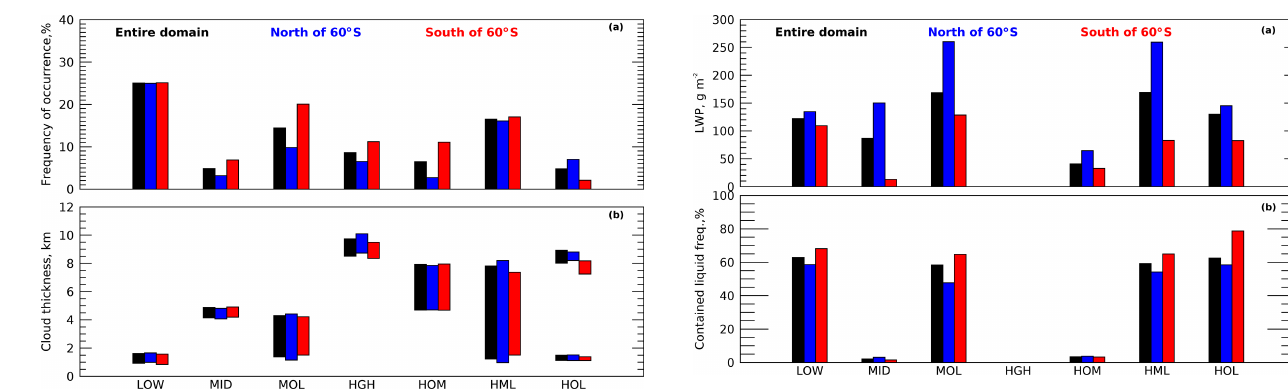
Figure 3. (a) Occurrence frequencies of categorized clouds by their vertical structures. LOW refers to single-layered low clouds ( H base and H top ≤ 3km). MID refers to single-layered middle clouds ( H base > 3km and H top ≤ 6km). MOL refers to MID over LOW ( H base < 3km and H top ≤ 6km). HGH refers to single- layered high clouds ( H base > 6km). HOM refers to HGH over MID (3km < H base < 6km and H top > 6km). HML refers to HGH over MID and LOW ( H base < 3km and H top ≥ 6km with a MID layer). HOL refers to HGH over LOW (LOW and HGH appear at the same time). (b) Cloud thickness for each type of cloud is shown with bars. The tops and bottoms of the bars represent the maximum cloud-top and minimum cloud base heights, respectively. Black, blue, and red bars represent the entire domain (lat. 41–69 ◦ S, long. 60–160 ◦ E), north of 60 ◦ S (NSO), and south of 60 ◦ S (SSO), respectively, dur- ing the MARCUS field campaign (October 2017–March 2018).